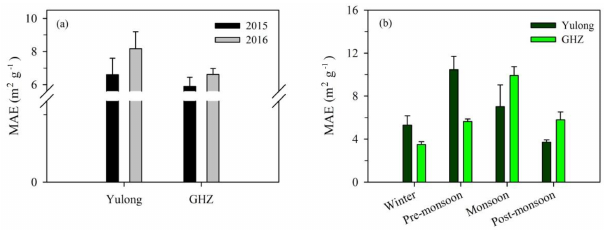
Figure 8. Histogram of (a) annual mean and (b) seasonal mean MAE values of atmospheric EC from Mt. Yulong and GHZ sam- pling sites during December 2014–December